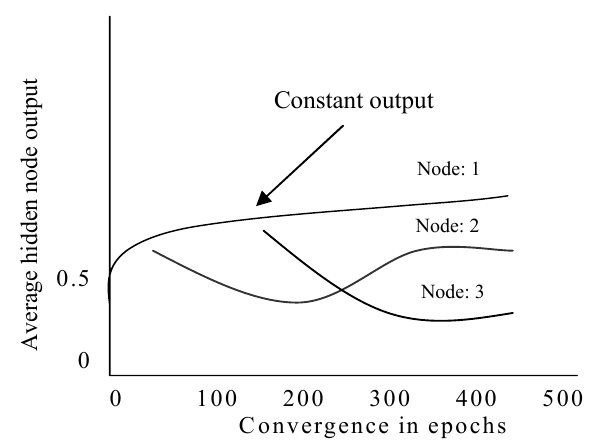
Figure 5. Output of the hidden